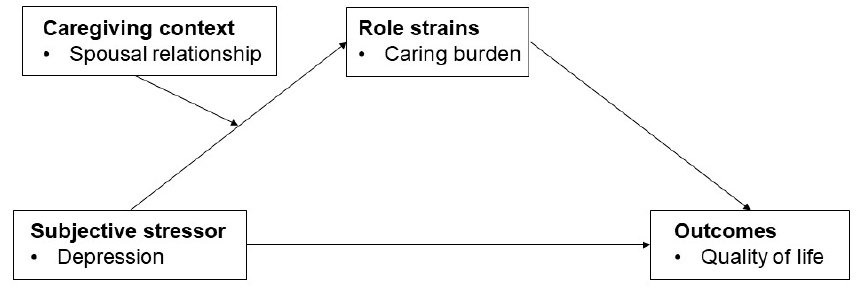
Figure 1. The conceptual model of the study.